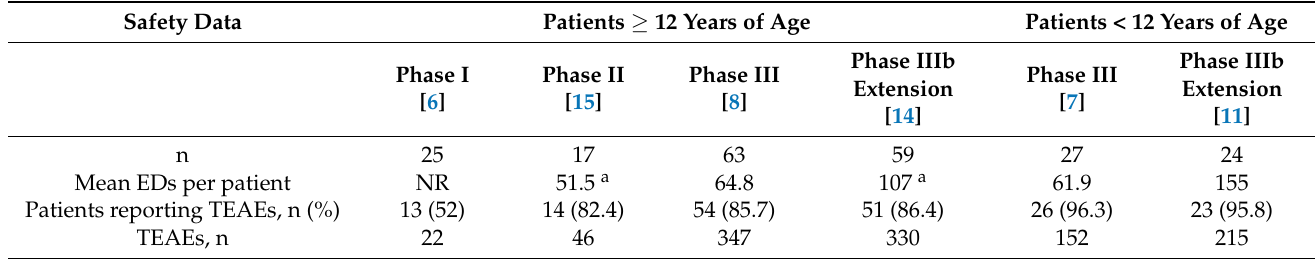
Table 3. Adverse event data for patients treated with rIX-FP in PROLONG-9FP